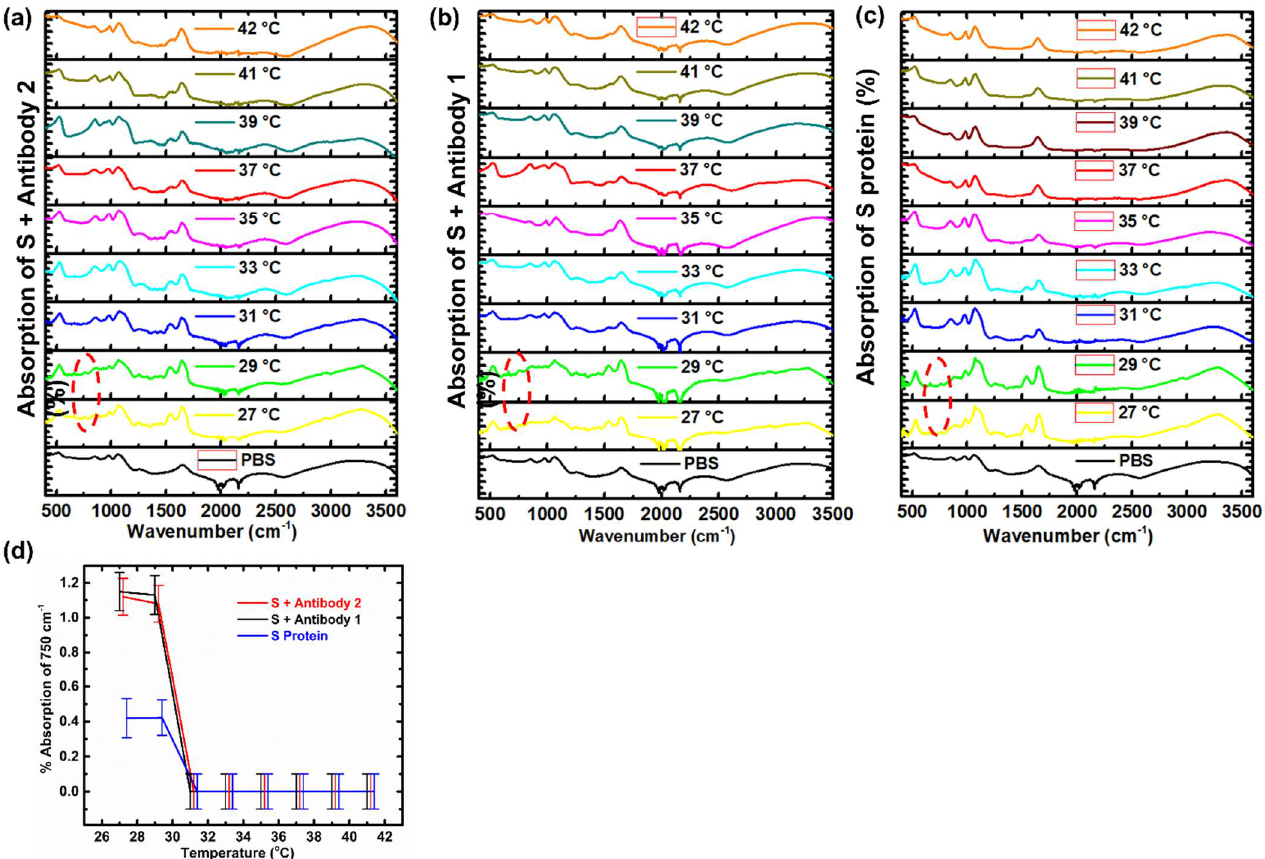
Figure 4. ( a ) The FTIR scan of SARS-CoV-2 spike protein/SARS-CoV-2 antibody (S + Antibody 2), obtained from more concentrated samples, showing visible 750 cm − 1 bands at 27–29 ◦ C (red circle), exclusively associated with the proteins but not found in the PBS solvent, attributed to the possible van der Waals bonding between the large pendant group such as phenyl. ( b ) Similar FTIR result of SARS-CoV-2 spike protein/SARS-CoV-1 antibody (S + Antibody 1) obtained from more concentrated samples, showing a visible 750 cm − 1 bands at 27–29 ◦ C (red circle). ( c ) Similar FTIR result of SARS-CoV-2 spike protein alone, obtained from more concentrated samples, showing a visible 750 cm − 1 bands at 27–29 ◦ C (red circle). ( d ) The infrared absorption of 750 cm − 1 under variable temperature of SARS-CoV-2 spike protein/SARS-CoV-2 antibody (S + Antibody 2), SARS-CoV-2 spike protein/SARS-CoV-1 antibody (S + Antibody 1), and the spike protein alone, obtained from the difference between the peak near 750 cm − 1 and the trough near 725 cm − 1 after subtracting that of the buffer solution. The associated error bars were estimated by combining the instrumental error and the possible deviation involved in the computation.